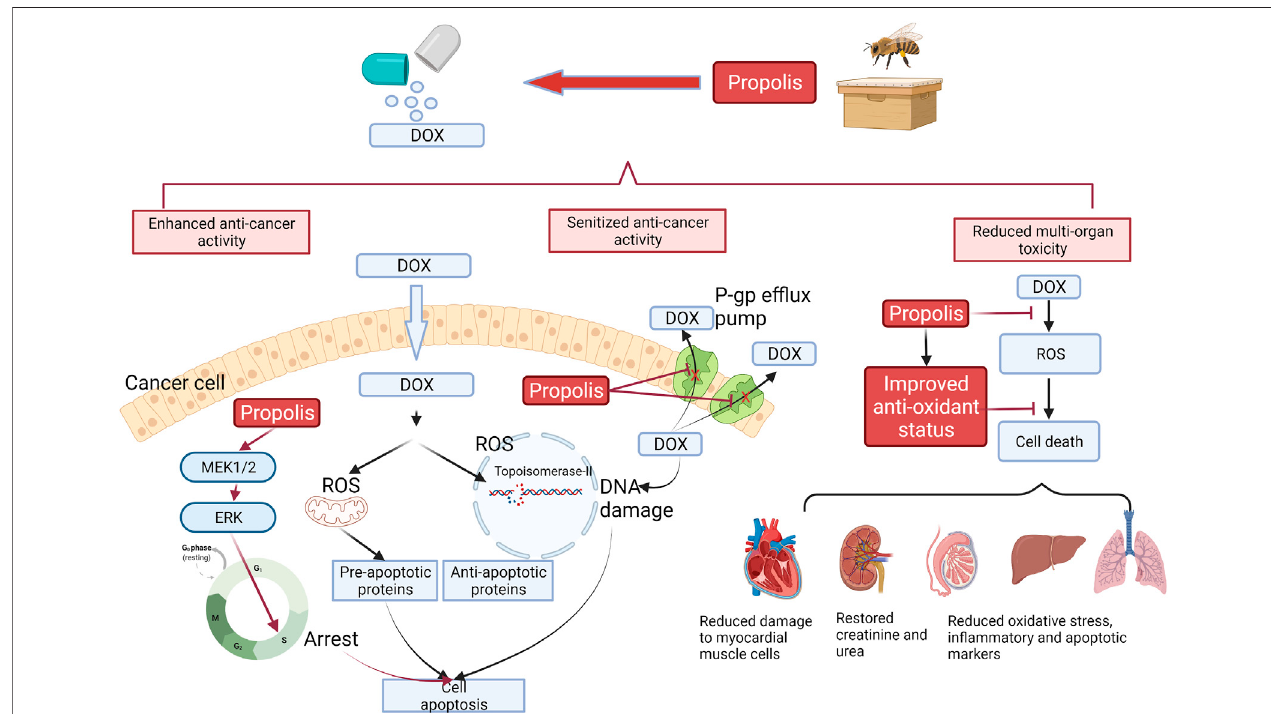
FIGURE 1 | Interaction of DOX with propolis extract, which led to enhanced cell apoptosis, sensitized anti-cancer activity, and reduced multi-organ toxicity based on preclinical evidence. Black arrows represent the action of DOX, whereas red arrows represent the action of propolis. In the cancer cells, propolis was reported to induce the MEK1/2-ERK-mediated apoptotic pathway, which caused the cell cycle arrest in the S phase and strengthened the induced cell death from DOX. Propolis alsoinhibitedtheP-gpef fl uxpump,whichincreasedtheintracellularconcentrationofDOX.ThisactionreducedthechemoresistanceofcancercellstoDOX.Onthe contrary, the improved anti-oxidant status from propolis by scavenging ROS and increased production of anti-oxidant enzymes protected multi-organs in the body against the toxicity from DOX.